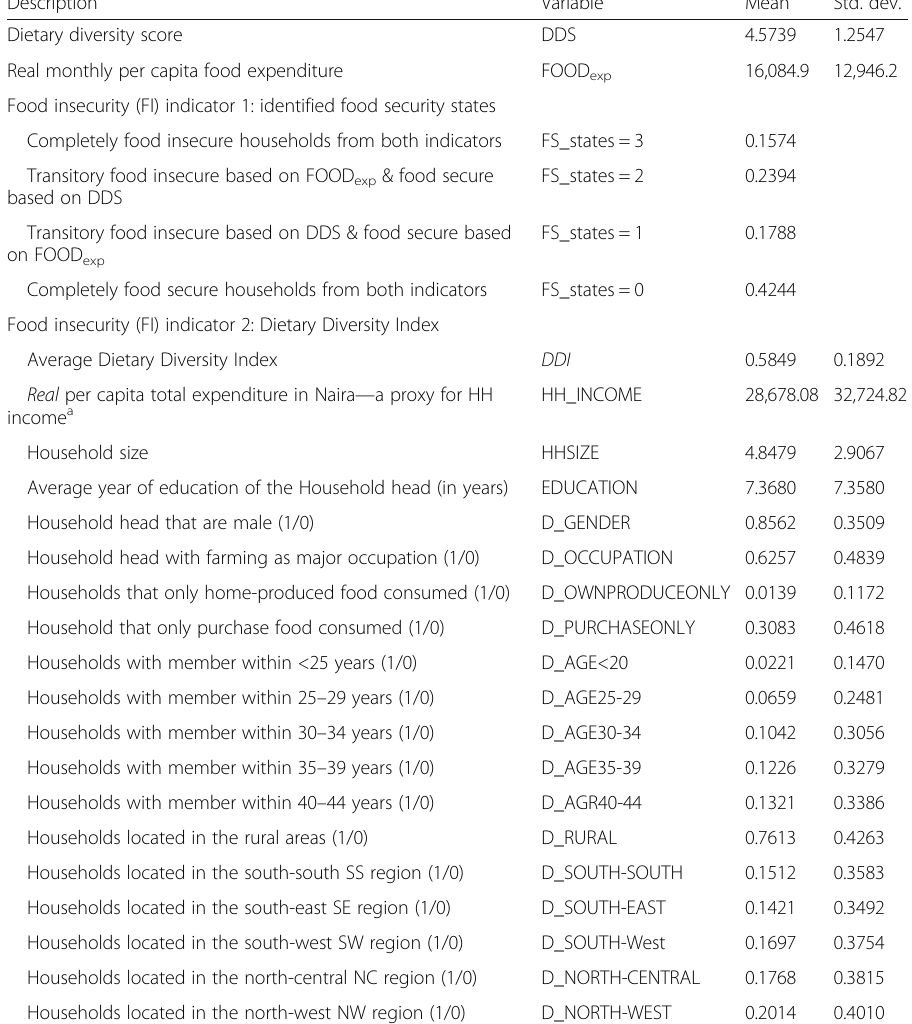
Table 1 Summary statistics of the variables and food security